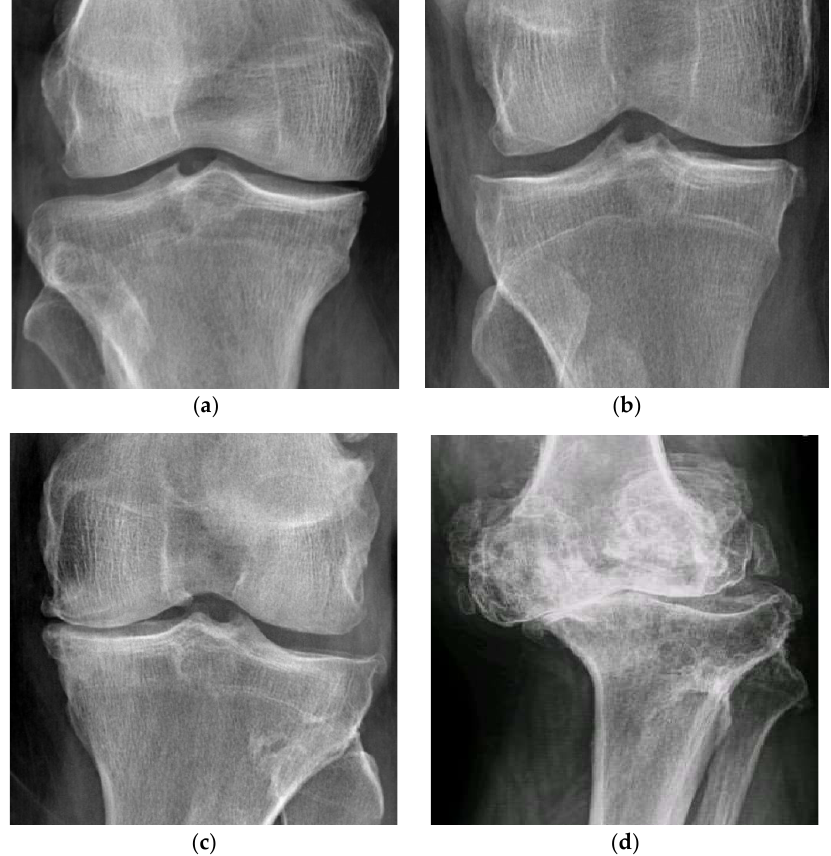
Figure 1. KL classification and illustration of KOA severity, SMUIS X-Ray collection of the